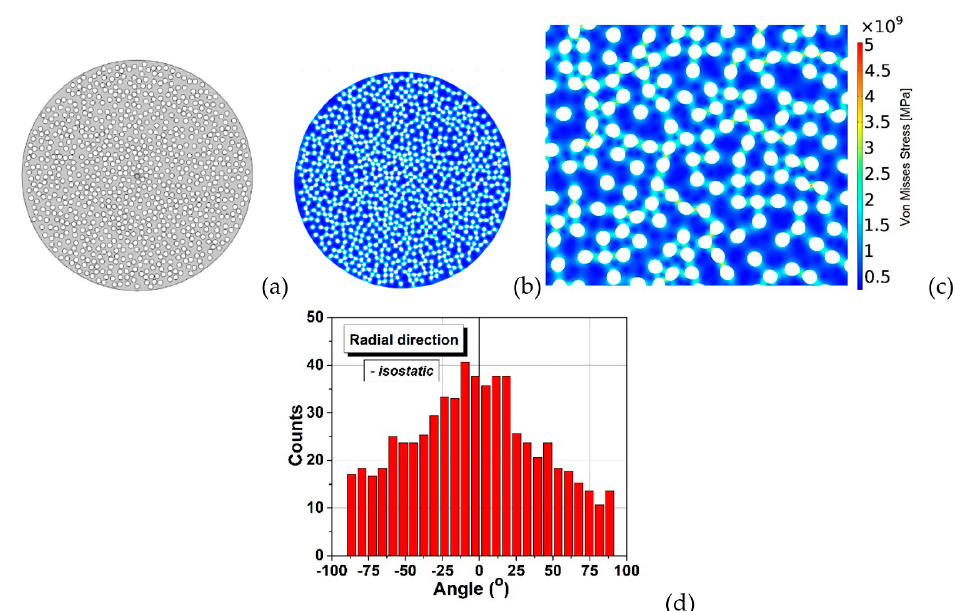
Figure 6. Schematic of isostatic pressing: ( a ) pressure applied only along the cylinder axis, ( b ) after isostatic pressing and deformation; ( c ) isostatically deformed structure; ( d ) angular distribution of inclusions derived for the case of isostatic pressing.